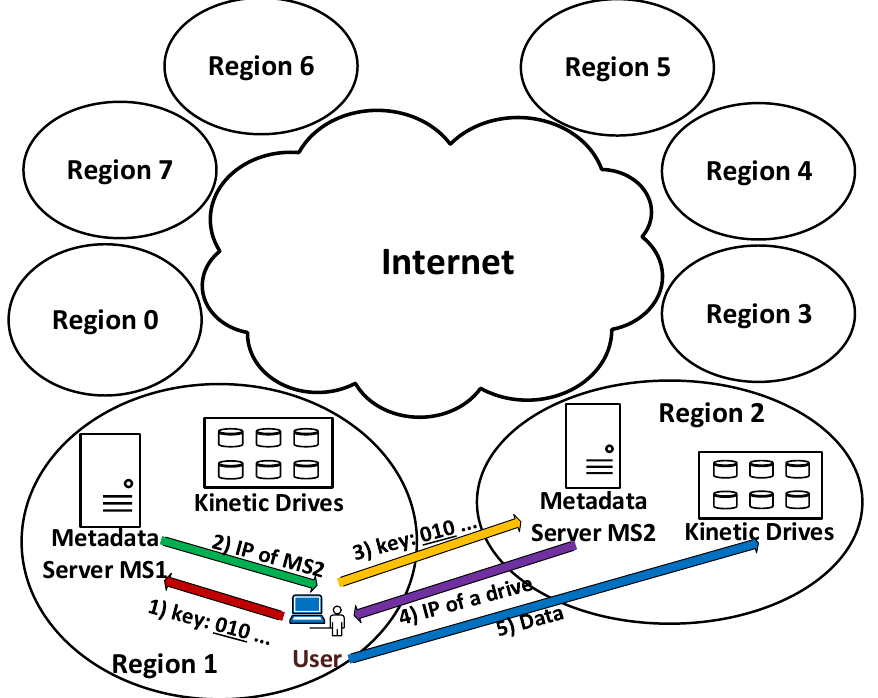
Figure 6. An example of our key-value store system. MS, metadata